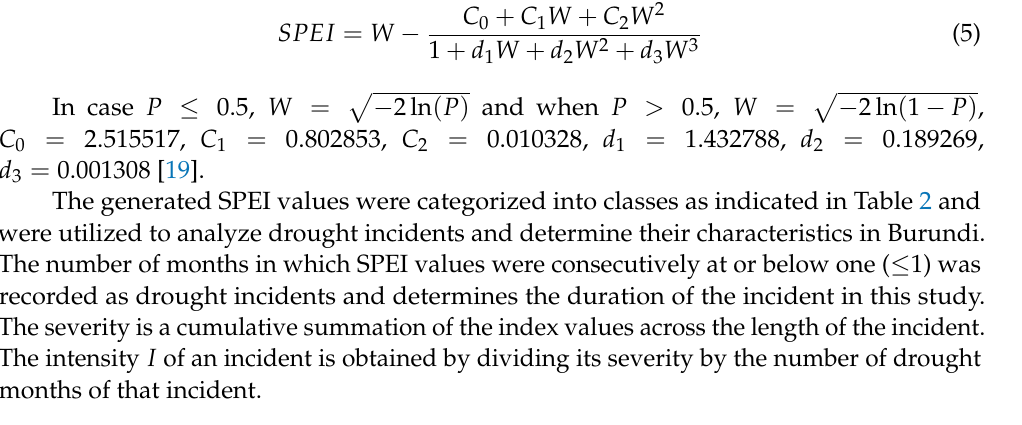
Table 2. Classification of dryness and wetness according to the SPEI index. SPEI Values Categories of Climatic Moisture ≥ 2.00 Extremely wet 1.50 to 1.99 Severely wet 1.00 to 1.49 Moderately wet Near normal Severe dry ≤− 2 Extremely